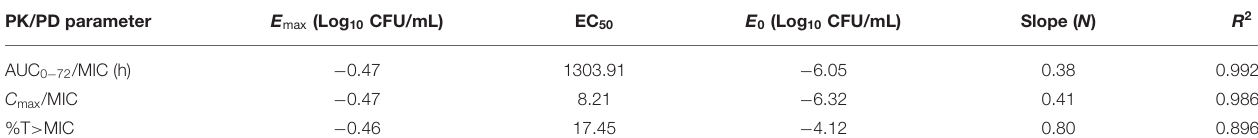
TABLE 2 | Estimation of PK/PD parameters, and data are derived from the E max model. PK/PD parameter